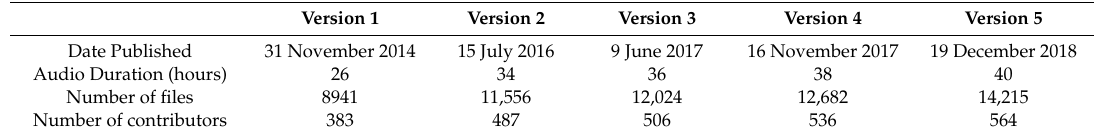
Table 3. Published versions of the Paldaruo Speech